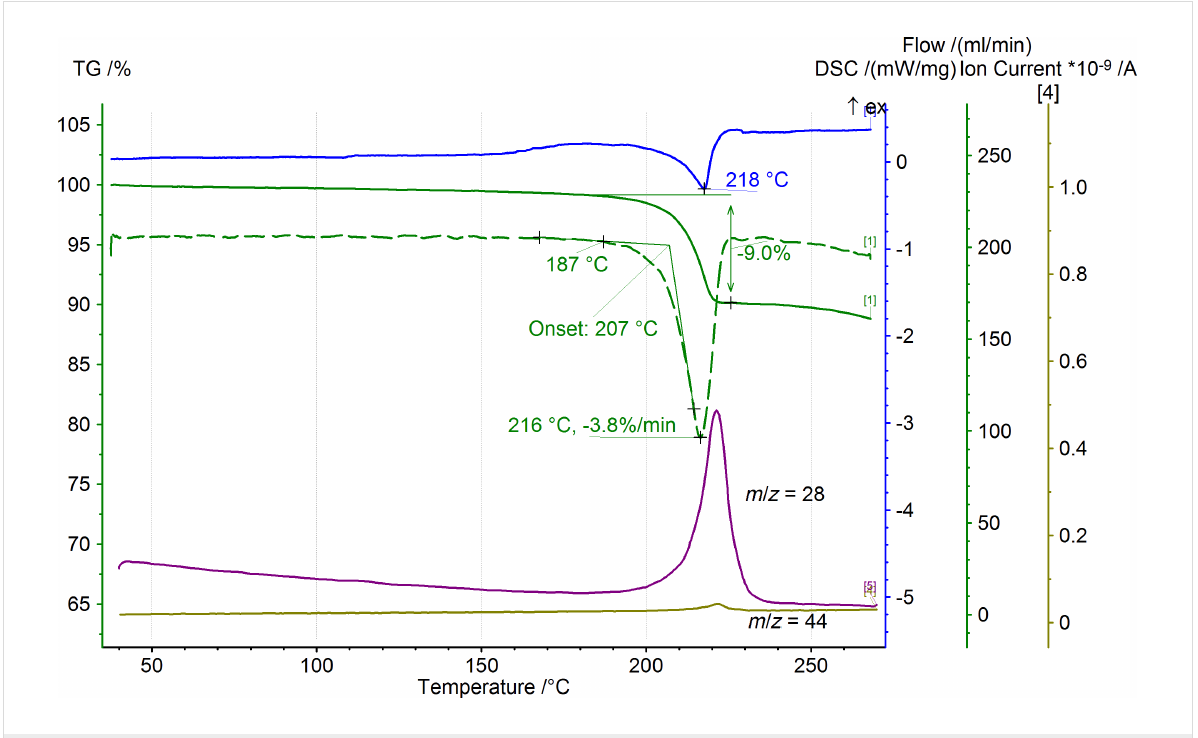
Figure 4: STA plot of thermolysis of PQT 1a . Blue solid curve: DSC; green solid curve: TG; greed dashed curve: DTG; violet solid curve: MID ( m / z = 28); brown solid curve: MID ( m / z = 44); heating rate: 5 °C/min.